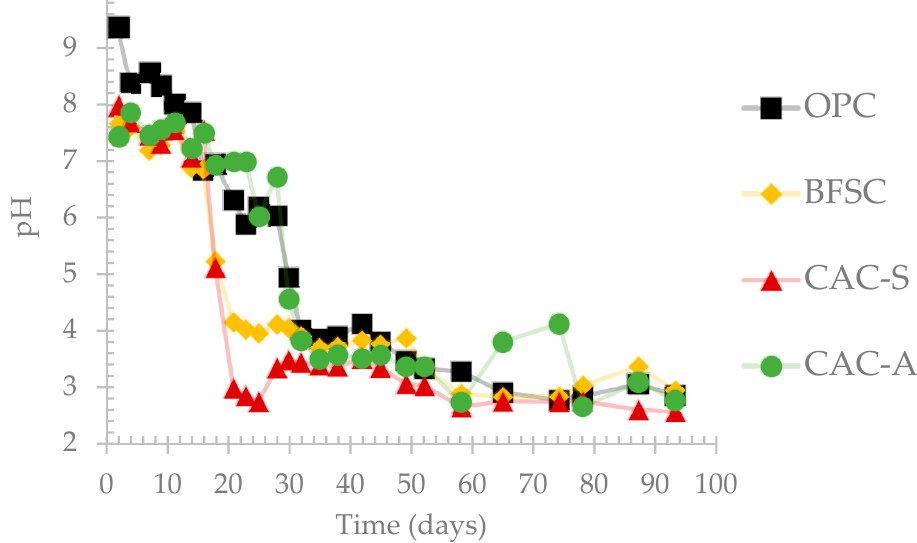
Figure 4. Evolution of the pH of the leaching solution during the exposure period.